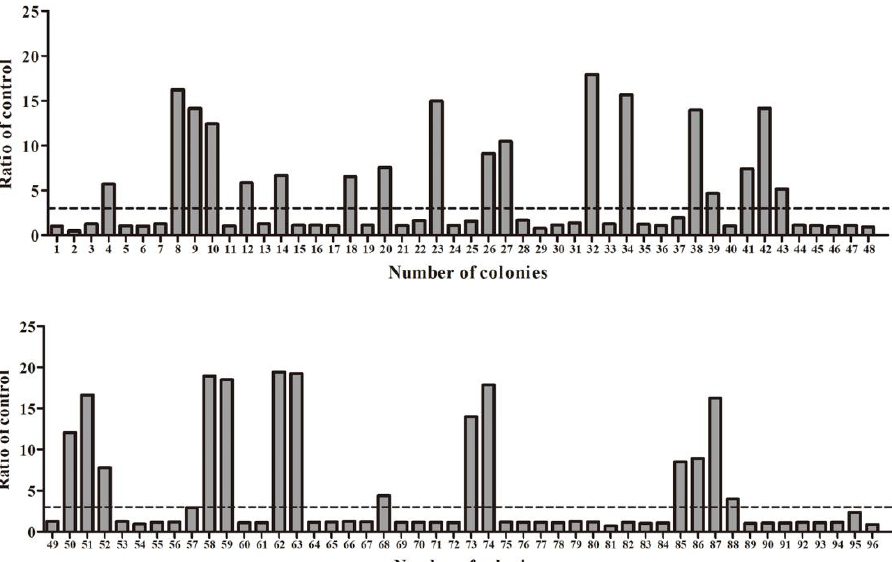
Figure 4. PE-ELISA for the identification of positive colonies. A ratio of higher than 3 was considered positive.